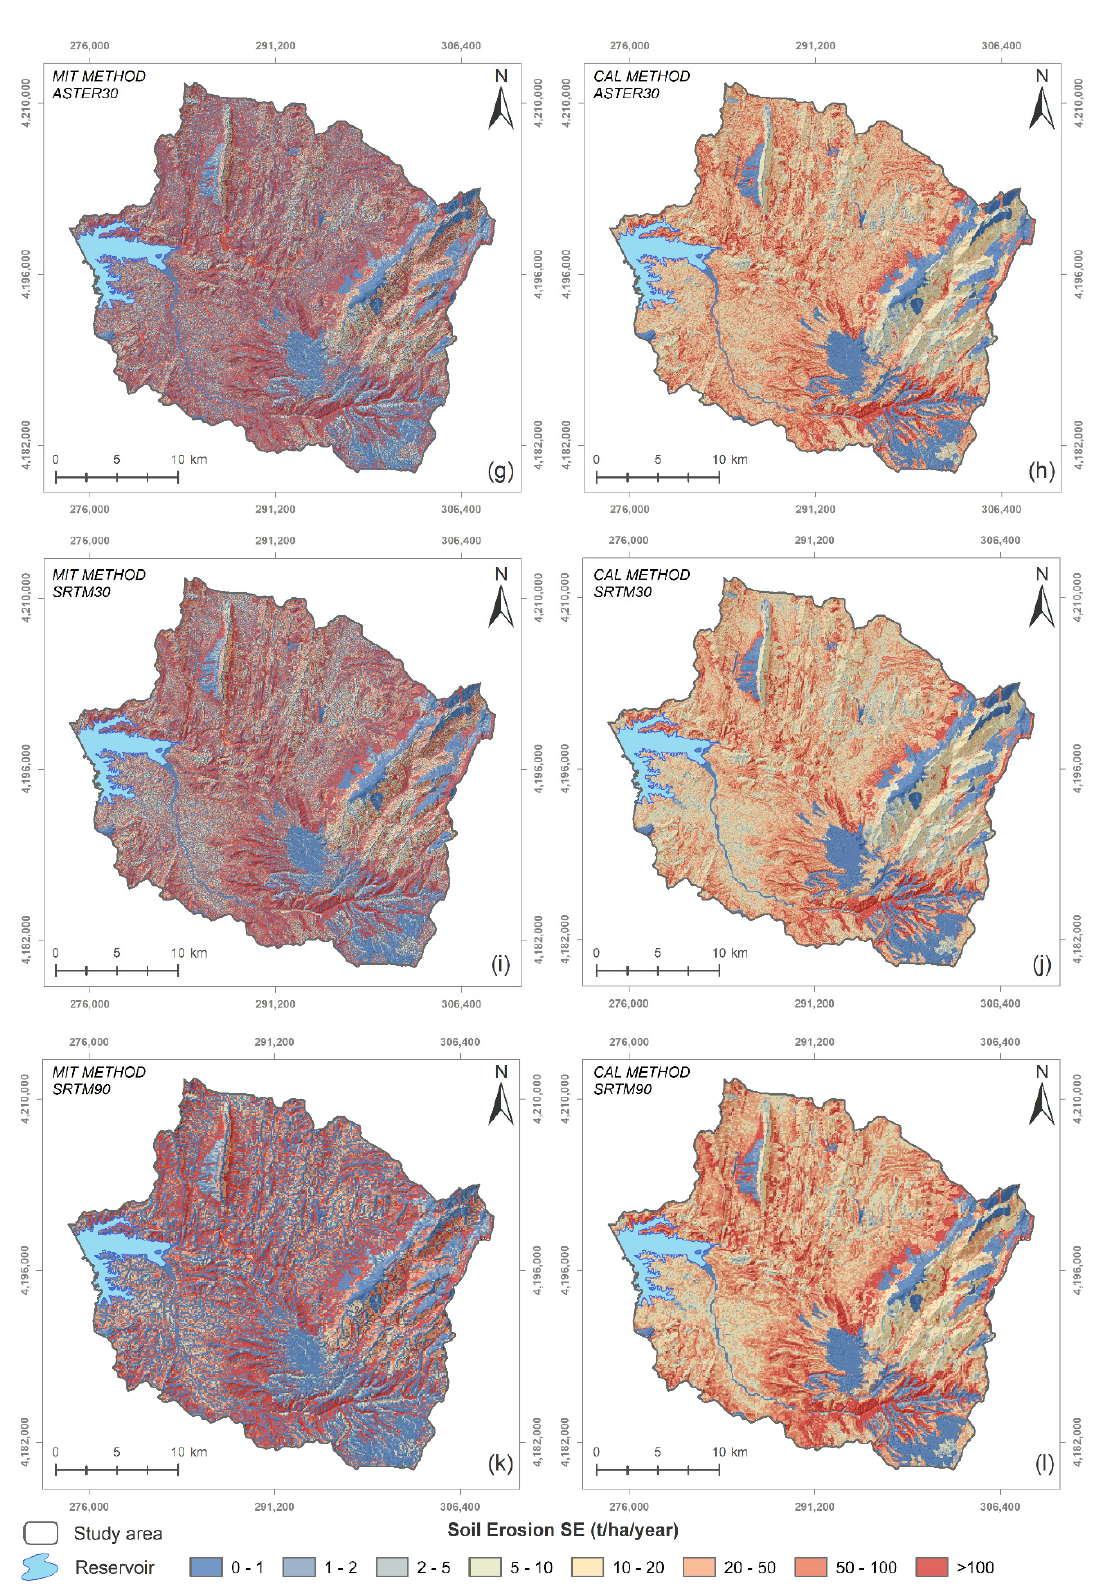
Figure A7. Maps of soil erosion annual rates (SE) calculated with the LS factor computed with the MIT method applied on ASTER30 ( g ), SRTM30 ( i ), SRTM90 ( k ) as well as the CAL method applied on ASTER30 ( h ), SRTM30 ( j ), and SRTM90 ( l ).